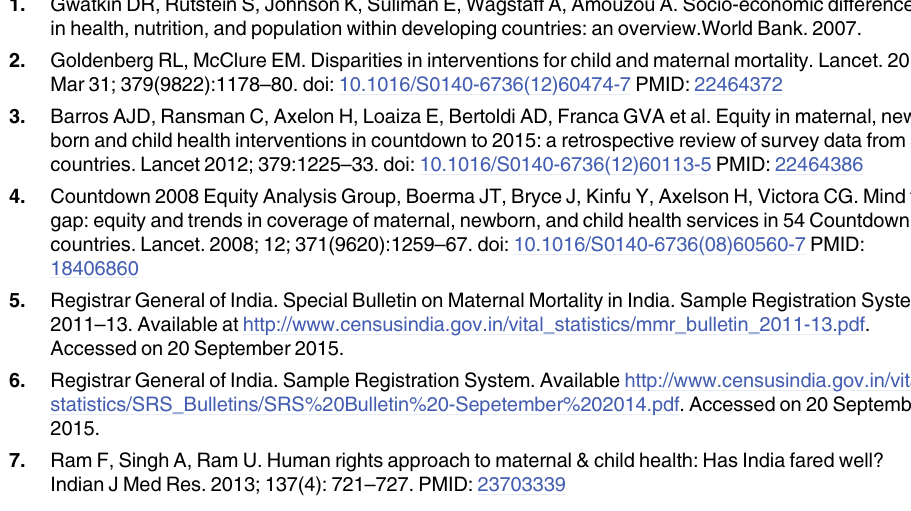
S2 Table. List of independent and dependent variables. S3 Table. Status of maternal and child health indicators pre, during and post NRHM implementation in Haryana as per DLHS rounds 2, 3 and 4. S4 Table. Trend of availability and accessibility of health facilities during and after NRHM implementation in